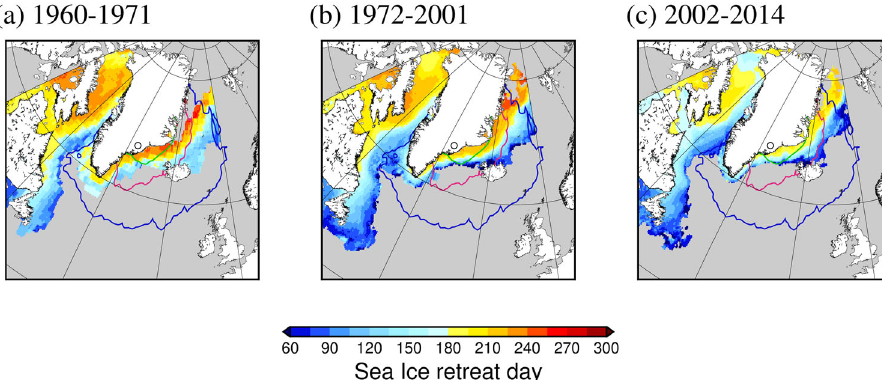
Fig. 5 Sea ice retreat day. a – c denote the sea ice retreat day of the year around Greenland (40°N – 85°N, 0°W – 80°W) for each period. Green, purple, and blue contours denote the regions greater than 40%, 60%, and 80% in the cumulative density function, respectively, of air mass probability revealed by the backward trajectory analysis during summer from 1960 – 2014. Black circles are the position of the SE-Dome